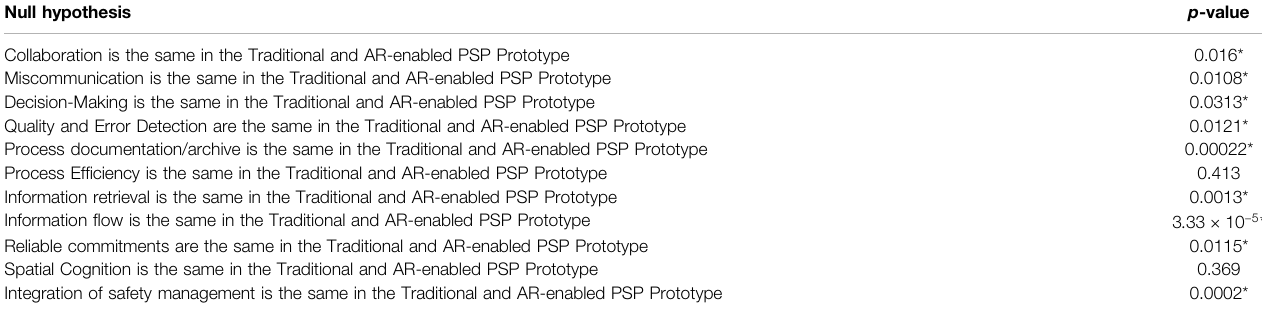
TABLE 7 | Hypotheses to compare the traditional PSP and the AR-enabled PSP prototype. Null hypothesis